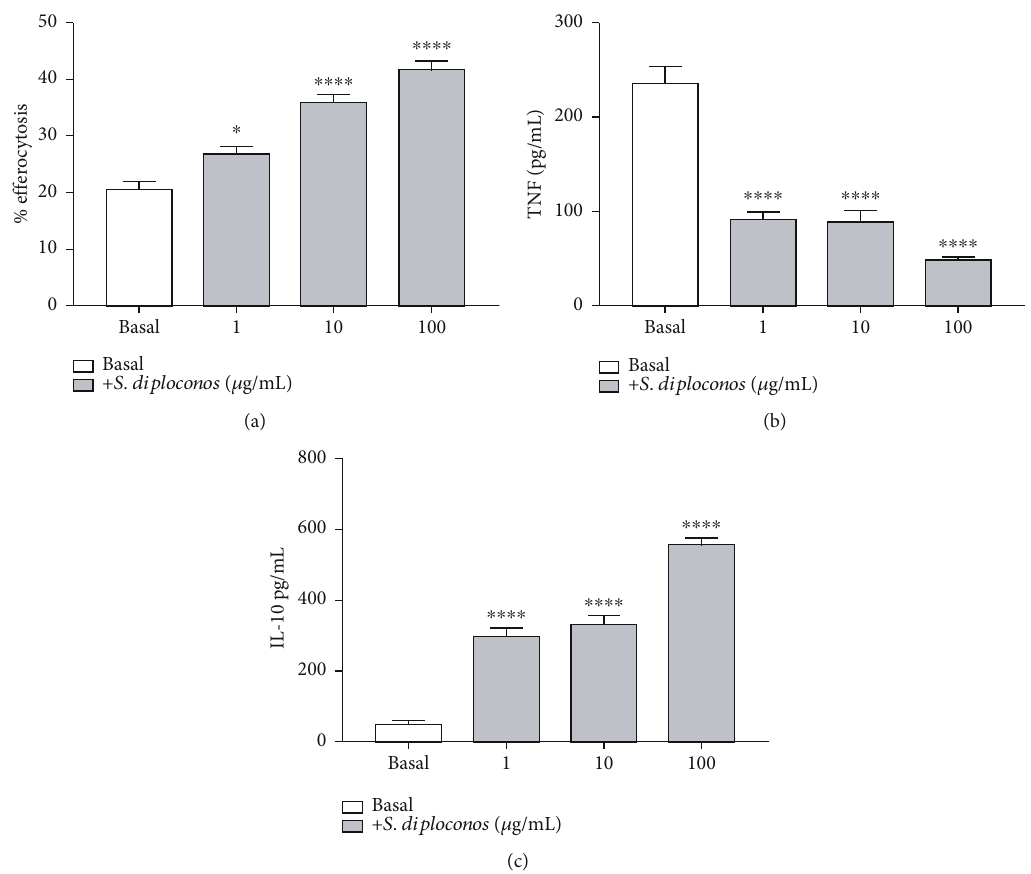
Figure 3: E ff ects of S. diploconos on e ff erocytosis. Quanti fi cation of e ff erocytosis (a) and supernatant levels of TNF α (b) and IL-10 (c). Data is expressed as a mean ± SEM of cells obtained from four animals. Statistical analysis was performed using one-way ANOVA followed by Tukey ’ s test. ∗ p < 0 : 05 ; ∗∗ p < 0 : 01 ; ∗∗∗ p < 0 : 001 , and ∗∗∗∗ p < 0 : 0001 vs.